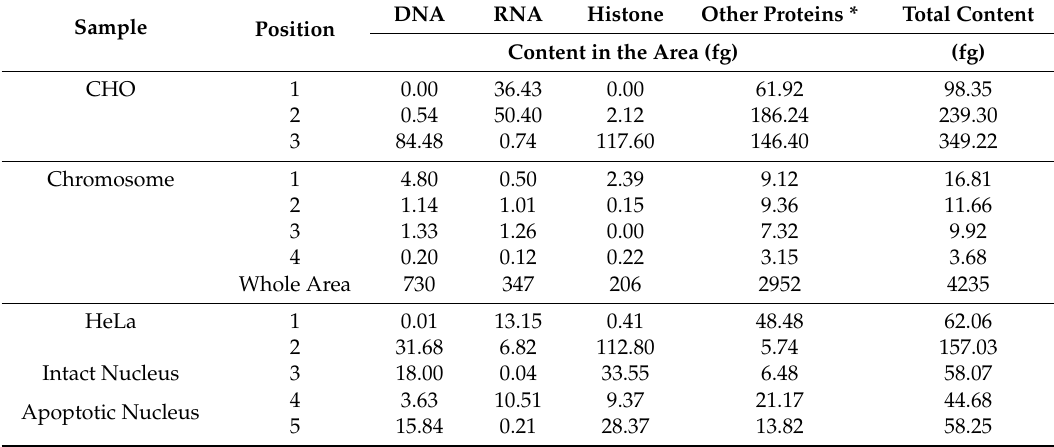
Table 1. Molecular contents of the regions of the positions shown in Figures 10–12, and of the entire chromosome